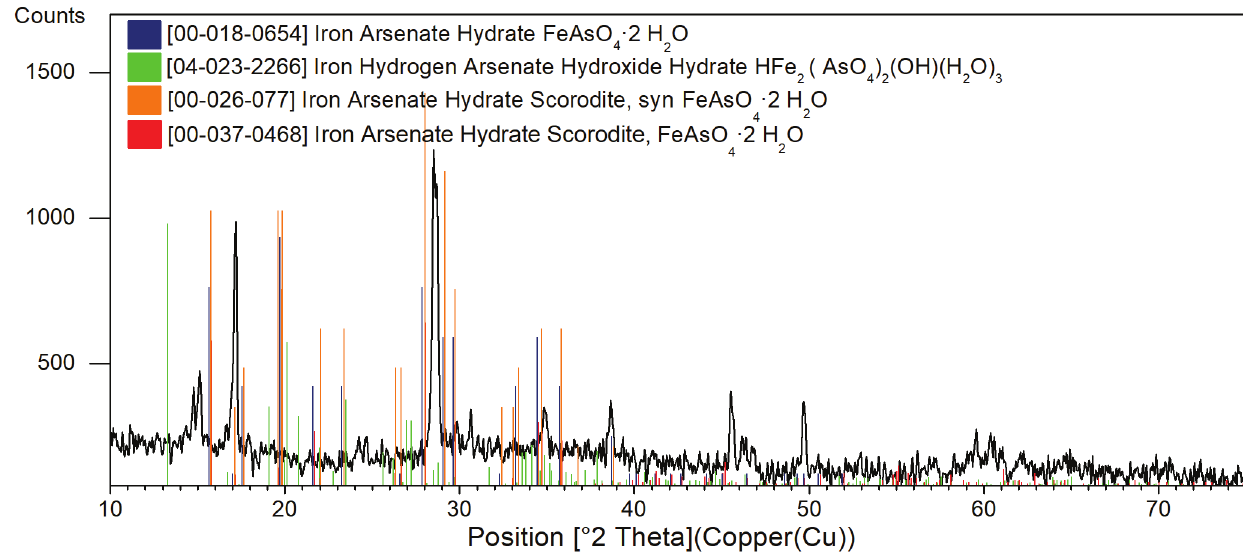
Figure 3. The XRD pattern of the synthetic scorodite.